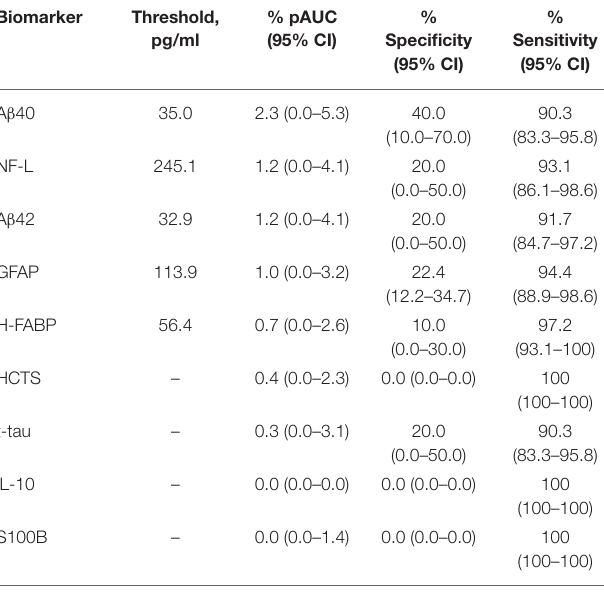
TABLE 4 | Individual abilities of the Helsinki Computerized Tomography Score and eight different biomarkers in discriminating patients with complete and incomplete recovery sorted by partial area under the curve of the receiver operating characteristic (all, n = 82; complete recovery, n = 10; incomplete recovery, n = 72).